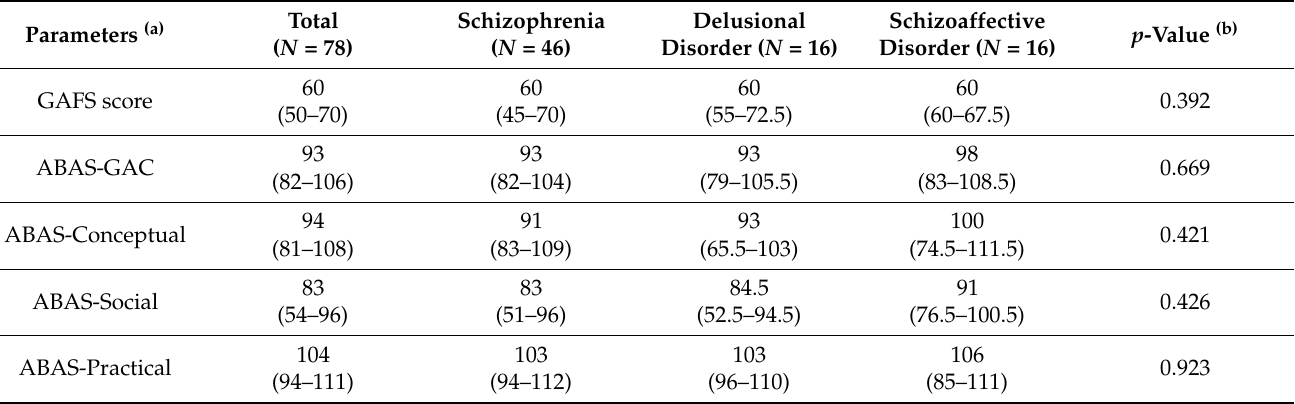
Table 3. Functioning characteristics of the patients with psychotic-spectrum disorders.